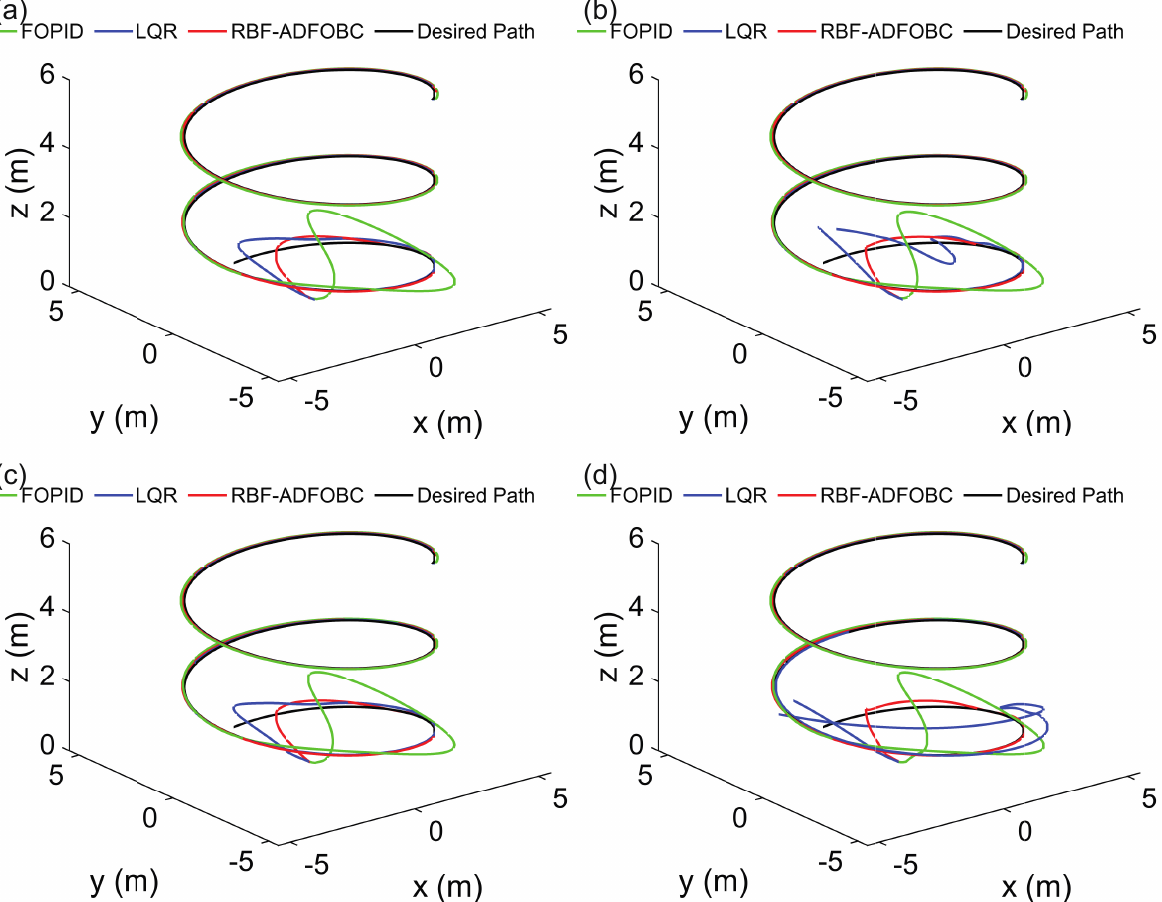
Figure 9. Comparison of the simulated trajectories with three controllers ( β = 0.5 in RBF-ADFOBC) in response to various payloads and uncertain input time delays: ( a ) d 3 = 2 m/s 2 and τ = 0.05 s, ( b ) d 3 = 2 m/s 2 and τ = 0.10 s, ( c ) d 3 = 4 m/s 2 and τ = 0.05 s, ( d ) d 3 = 4 m/s 2 and τ = 0.10 s. (Assume that d 1 = d 2 = d 4 = d 5 = d 6 = 0 and τ = τ 1 = τ 2 = τ 3 = τ 4 Table 19. Root mean squared error (RMSE) of the simulated tracks under different payloads and different input time delays for the three different controllers.